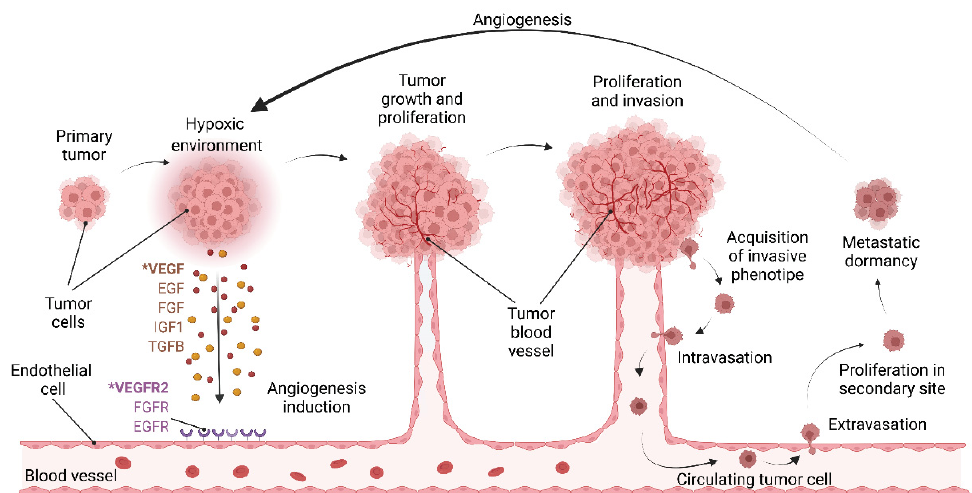
Figure 2. Tumor angiogenesis. Hypoxia within the tumor induces the release of different pro-angiogenic factors, such as VEGFs, EGF, FGF, IGF1 or TGFB1. VEGF-A is the major angiogenic activator and it induces angiogenesis upon binding to VEGFR2, mainly expressed by tumor endothelial cells. The new blood vessels allow exchange of oxygen, nutrients and waste products, leading to tumor growth and proliferation. Moreover, once cancer cells acquire a more invasive phenotype, they can intravasate into blood vessels and reach distant locations leading to metastasis. Disseminated tumor cells that have spread to a secondary site can enter a state of metastatic dormancy or induce angiogenesis and start proliferating.